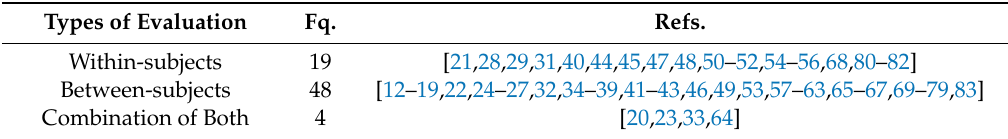
Table 10. Sample evaluation